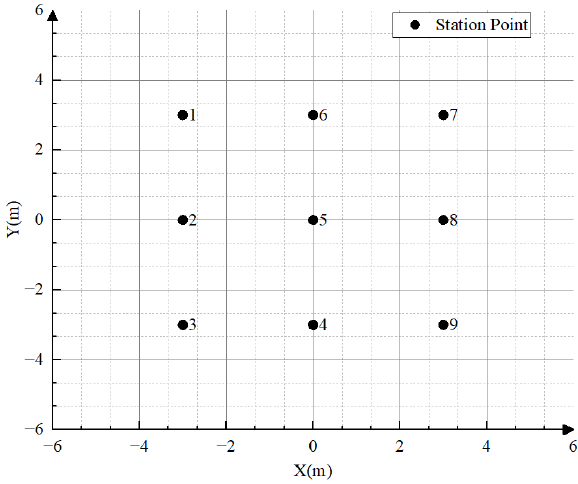
Figure 7. Arrangement of the observation array.